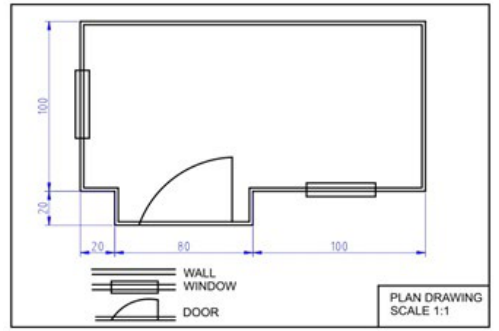
Figure 3: The plan drawing for the group’s mouse